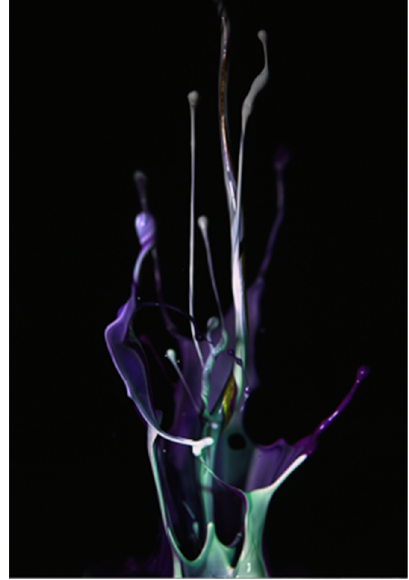
Figure 4. Fluid form created by sound vibration and captured by a high-speed camera.